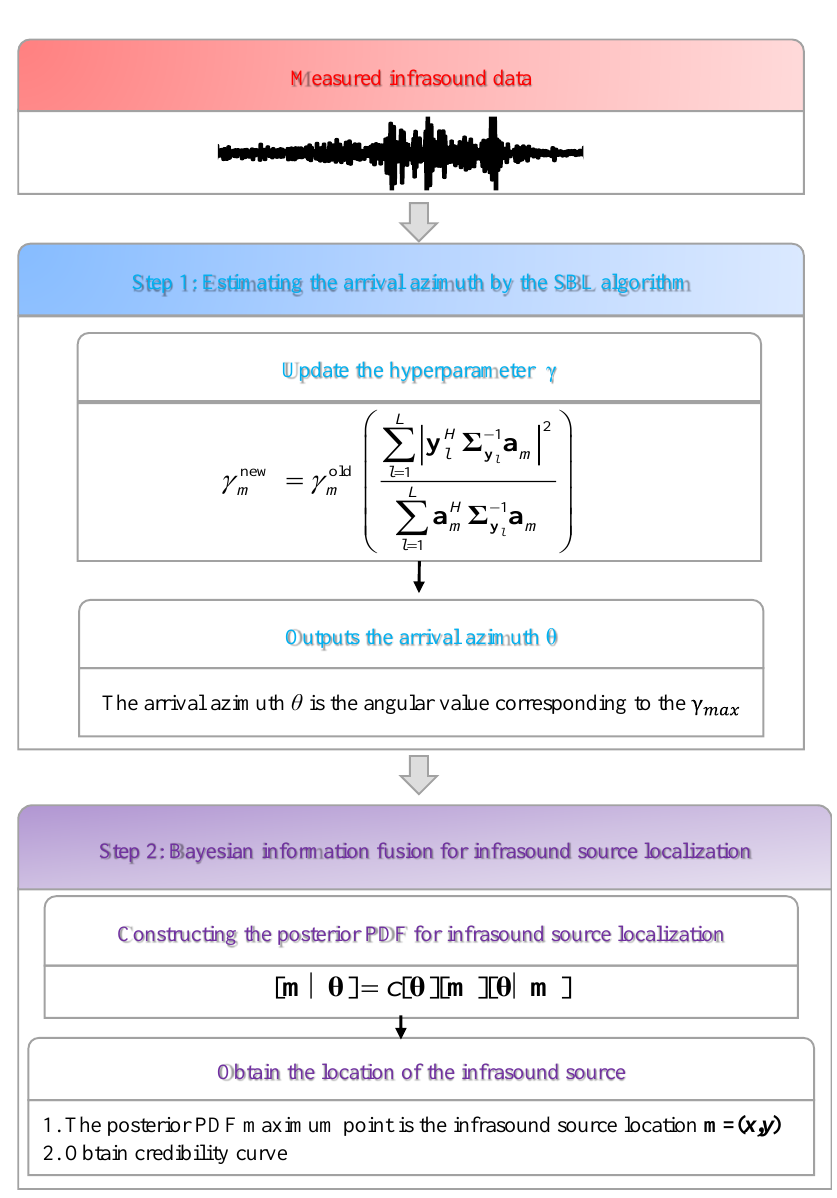
Figure 5. The technical flowchart of the infrasound source localization algorithm proposed in this paper. The first step is to estimate the arrival azimuth by the SBL algorithm by updating the hyperparameter gamma using Equation (28). The estimated value of the arrival azimuth is the angle corresponding to the γ max . The second step is the Bayesian information fusion for infrasound source localization. The posterior PDF maximum value is the infrasound source location m = ( x , y )